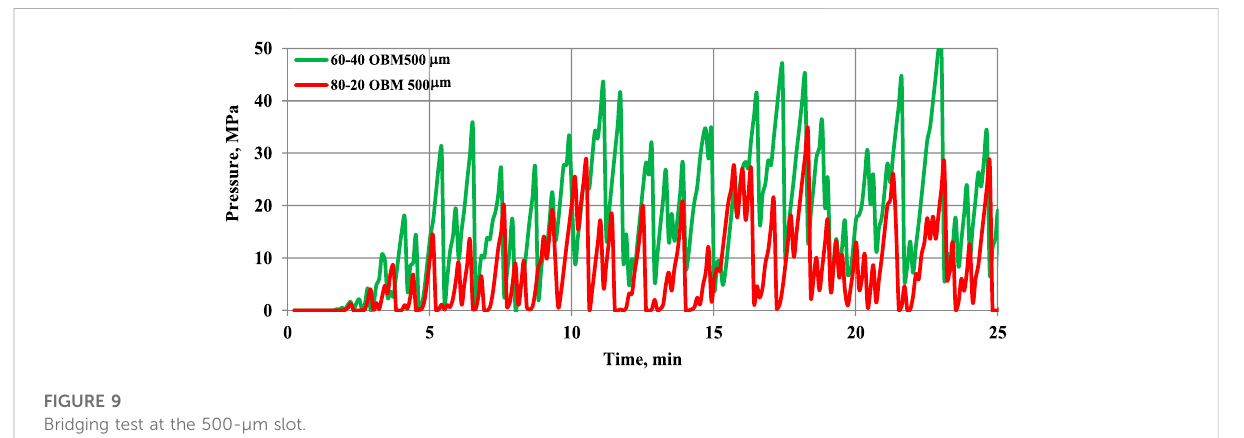
FIGURE 9 Bridging test at the 500- μ m